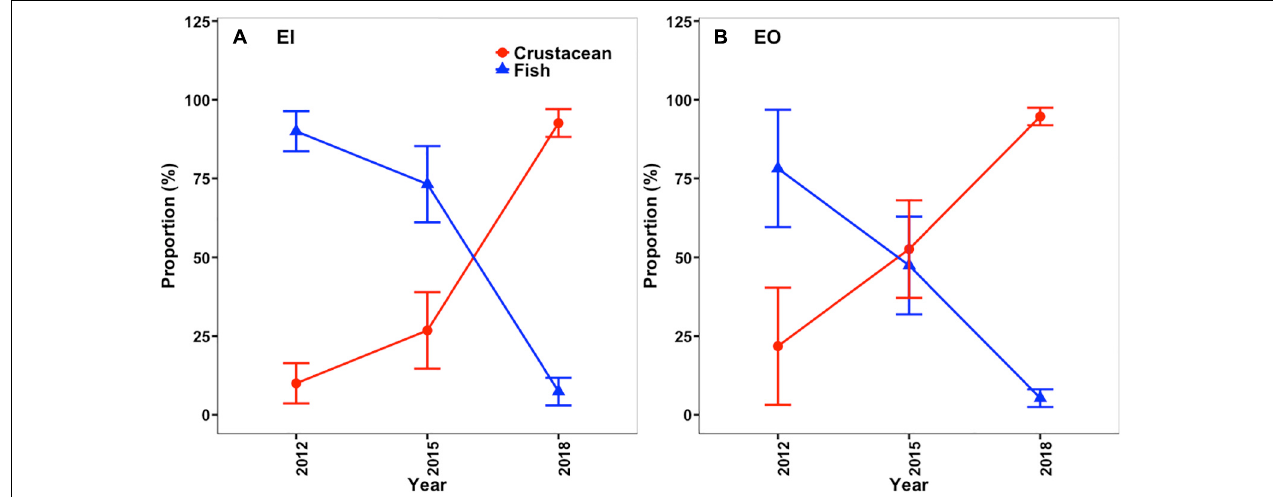
FIGURE 6 | Changes in diet composition of Platycephalus indicus in terms the percentage of crustacean (red line) and fish (blue line) prey items in their diet in inner Tolo channel [EI; mean ± SD; (A) ] and outer Tolo [EO; mean ± SD; (B) ] before (2012) and after (2015 and 2018) the trawl ban, according to the values in the posterior distributions estimated using the MixSIAR